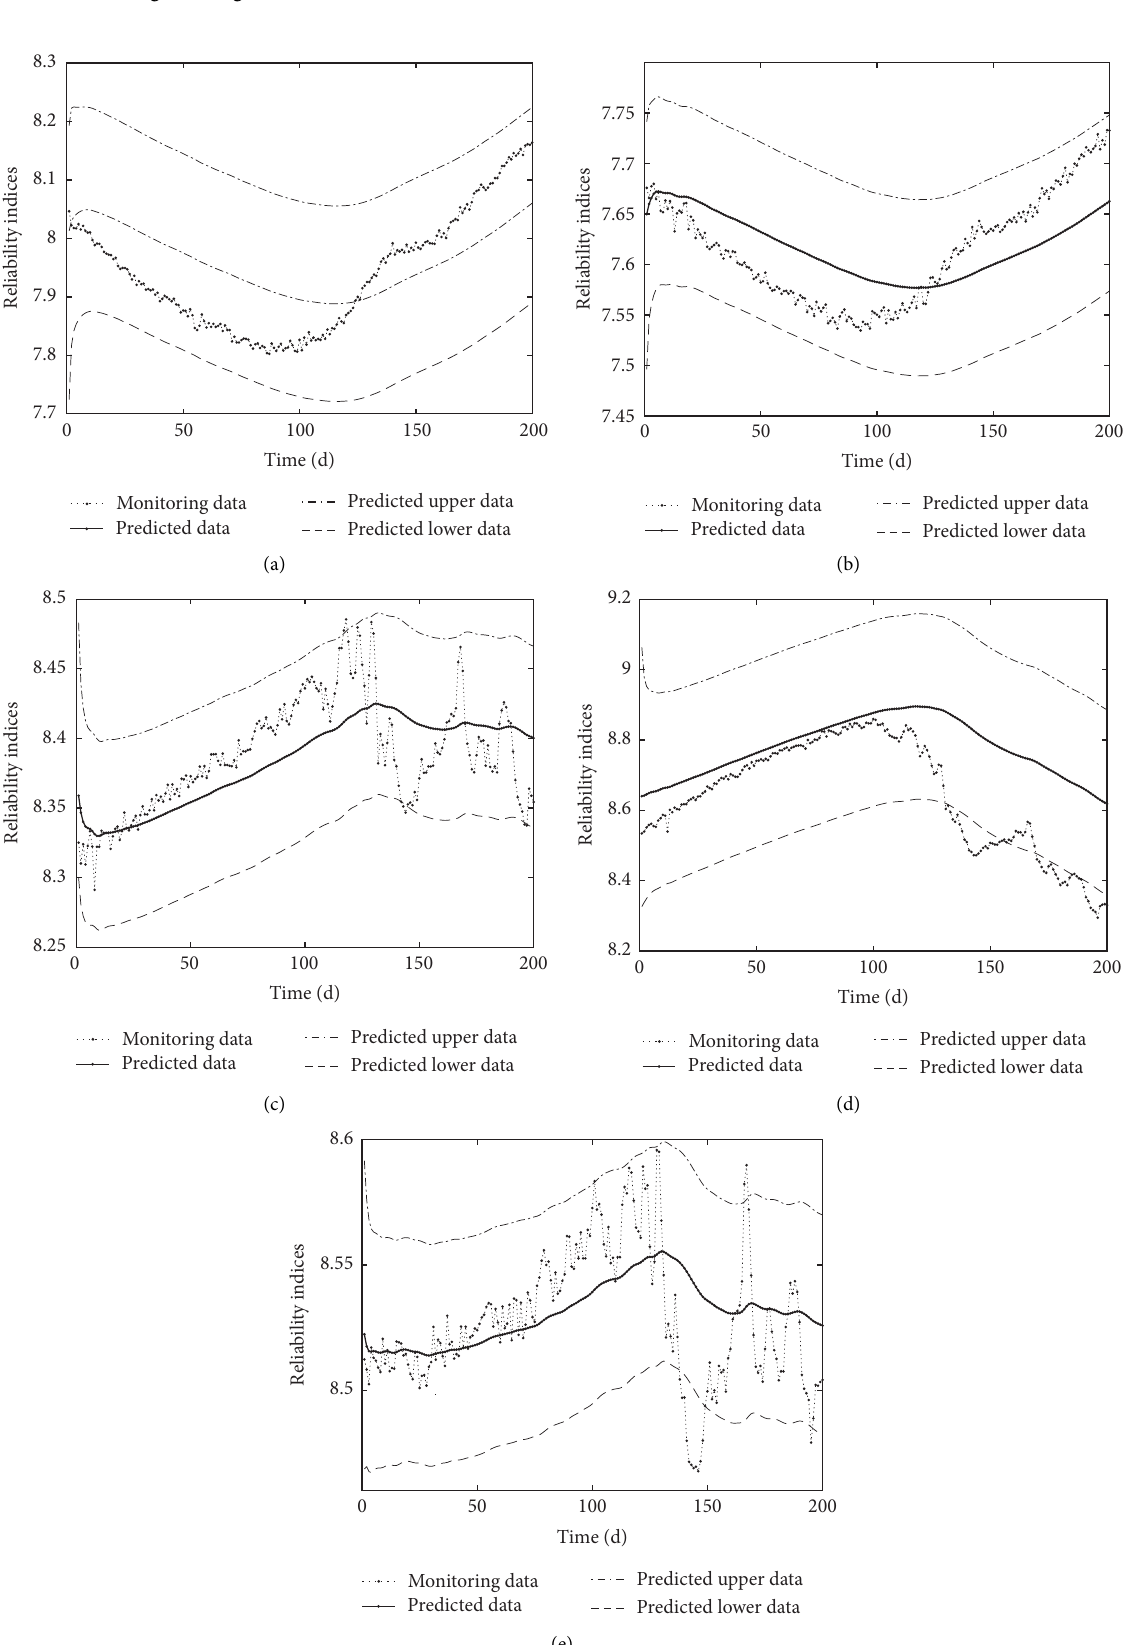
Figure 7: Predicted reliability indices of the five sections. (a) Section A. (b) Section B. (c) Section C. (d) Section D. (e) Section